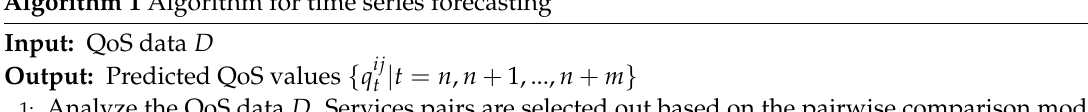
Algorithm 1 Algorithm for time series